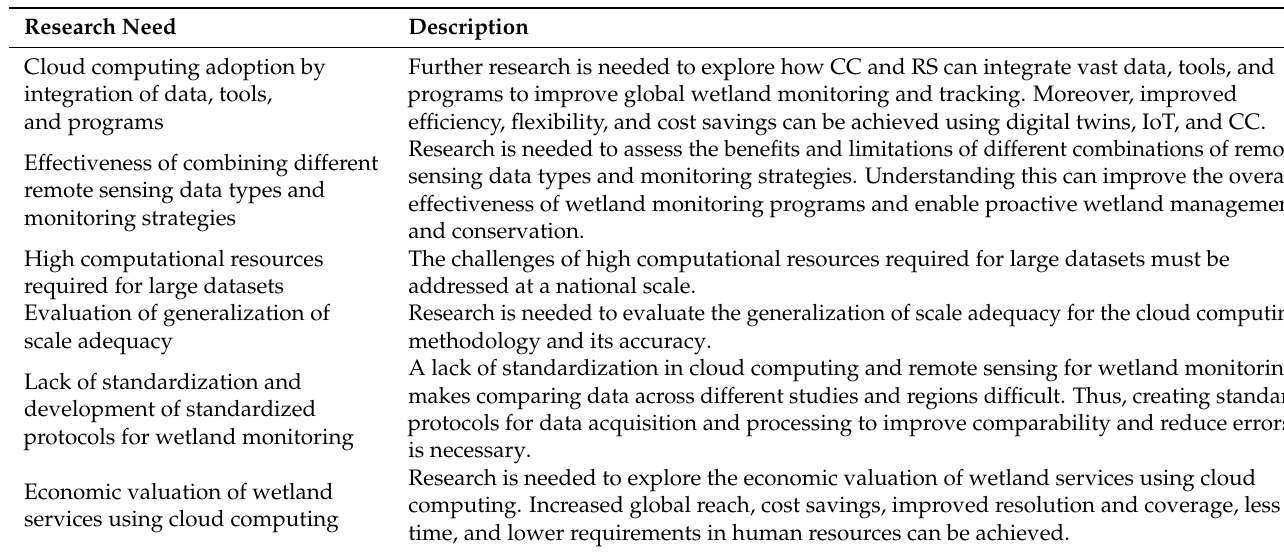
Table 6. Summary of Research Needs Identified in the